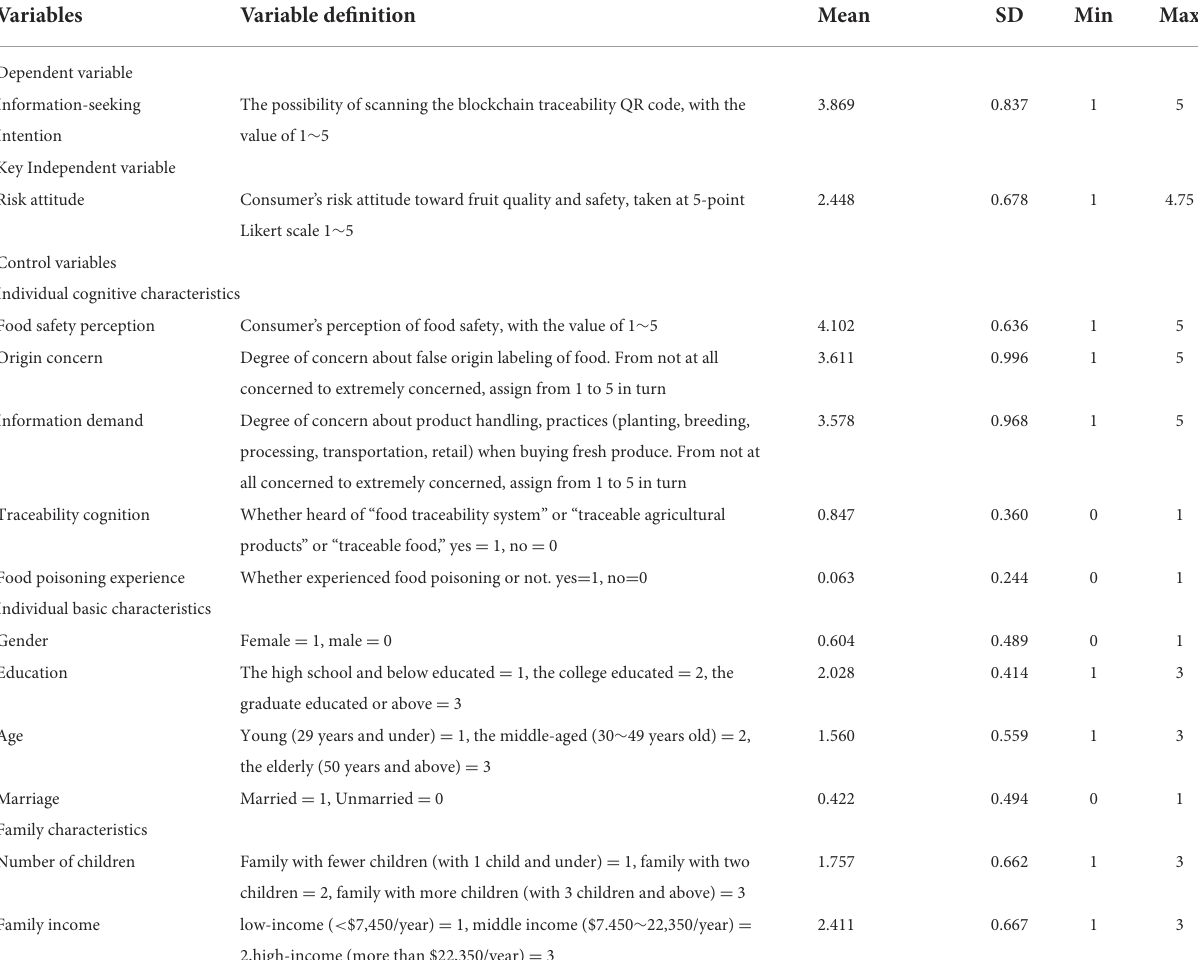
TABLE 1 Variable definitions and summary